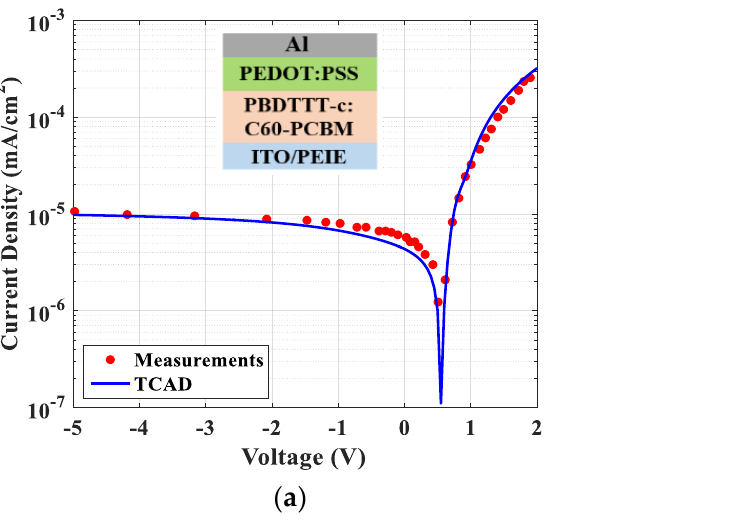
Figure 2. Calibration of experimental wideband organic PD ( a ) illuminated J-V characteristics (530 nm and 0.3 W/m 2 ). The main structure of the PD is shown in the inset and ( b ) EQE characteristics.